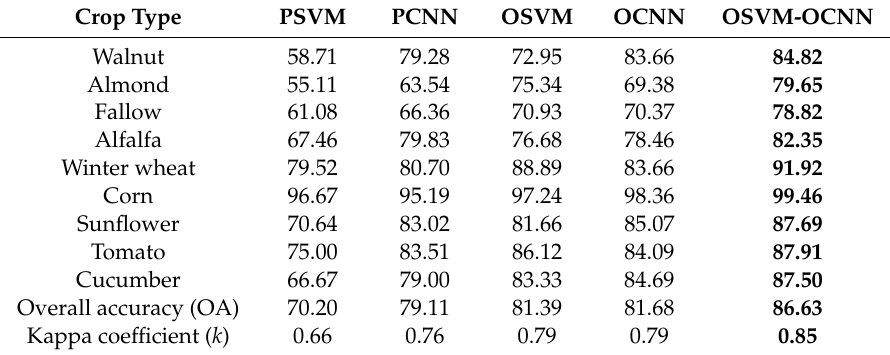
Table 4. Overall accuracy as well as per-class accuracy achieved by the PSVM, PCNN, OSVM, OCNN and OSVM-OCNN method with the RapidEye image in S2; the greatest classification accuracy per row is highlighted in bold